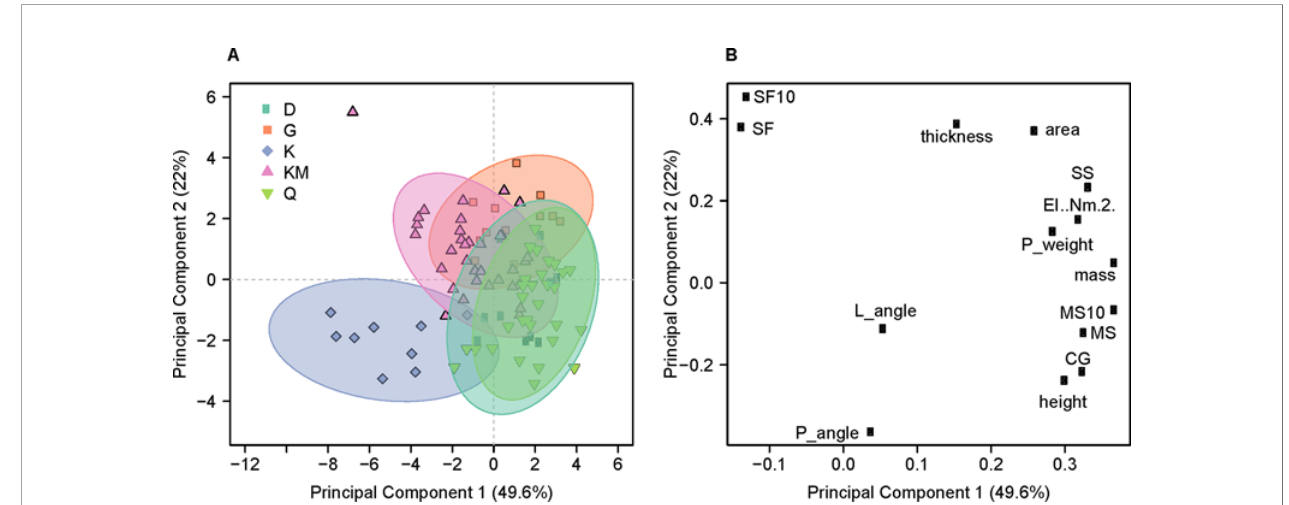
FIGURE 5 | Principal Component Analysis for the top two components. (A) Scores of the fi rst two principle components colored by genotype. Quncho (Q): green; Dukem (D): teal; kinde (K): purple; Key Murrie (KM): pink; and Gommadie (G): orange are shown for the 95 observations which had measurements for both panicle angle and panicle weight. Signi fi cant overlap is seen for Quncho and one of its parents, Dukem . Kinde is separated on both principle components. (B) Loadings of the fi rst two principle components. Panicle angle (P_angle) is highly correlated with lodging angle (L_angle). In a correlation circle plot, the angle formed by any two variables and the origin re fl ects their pairwise